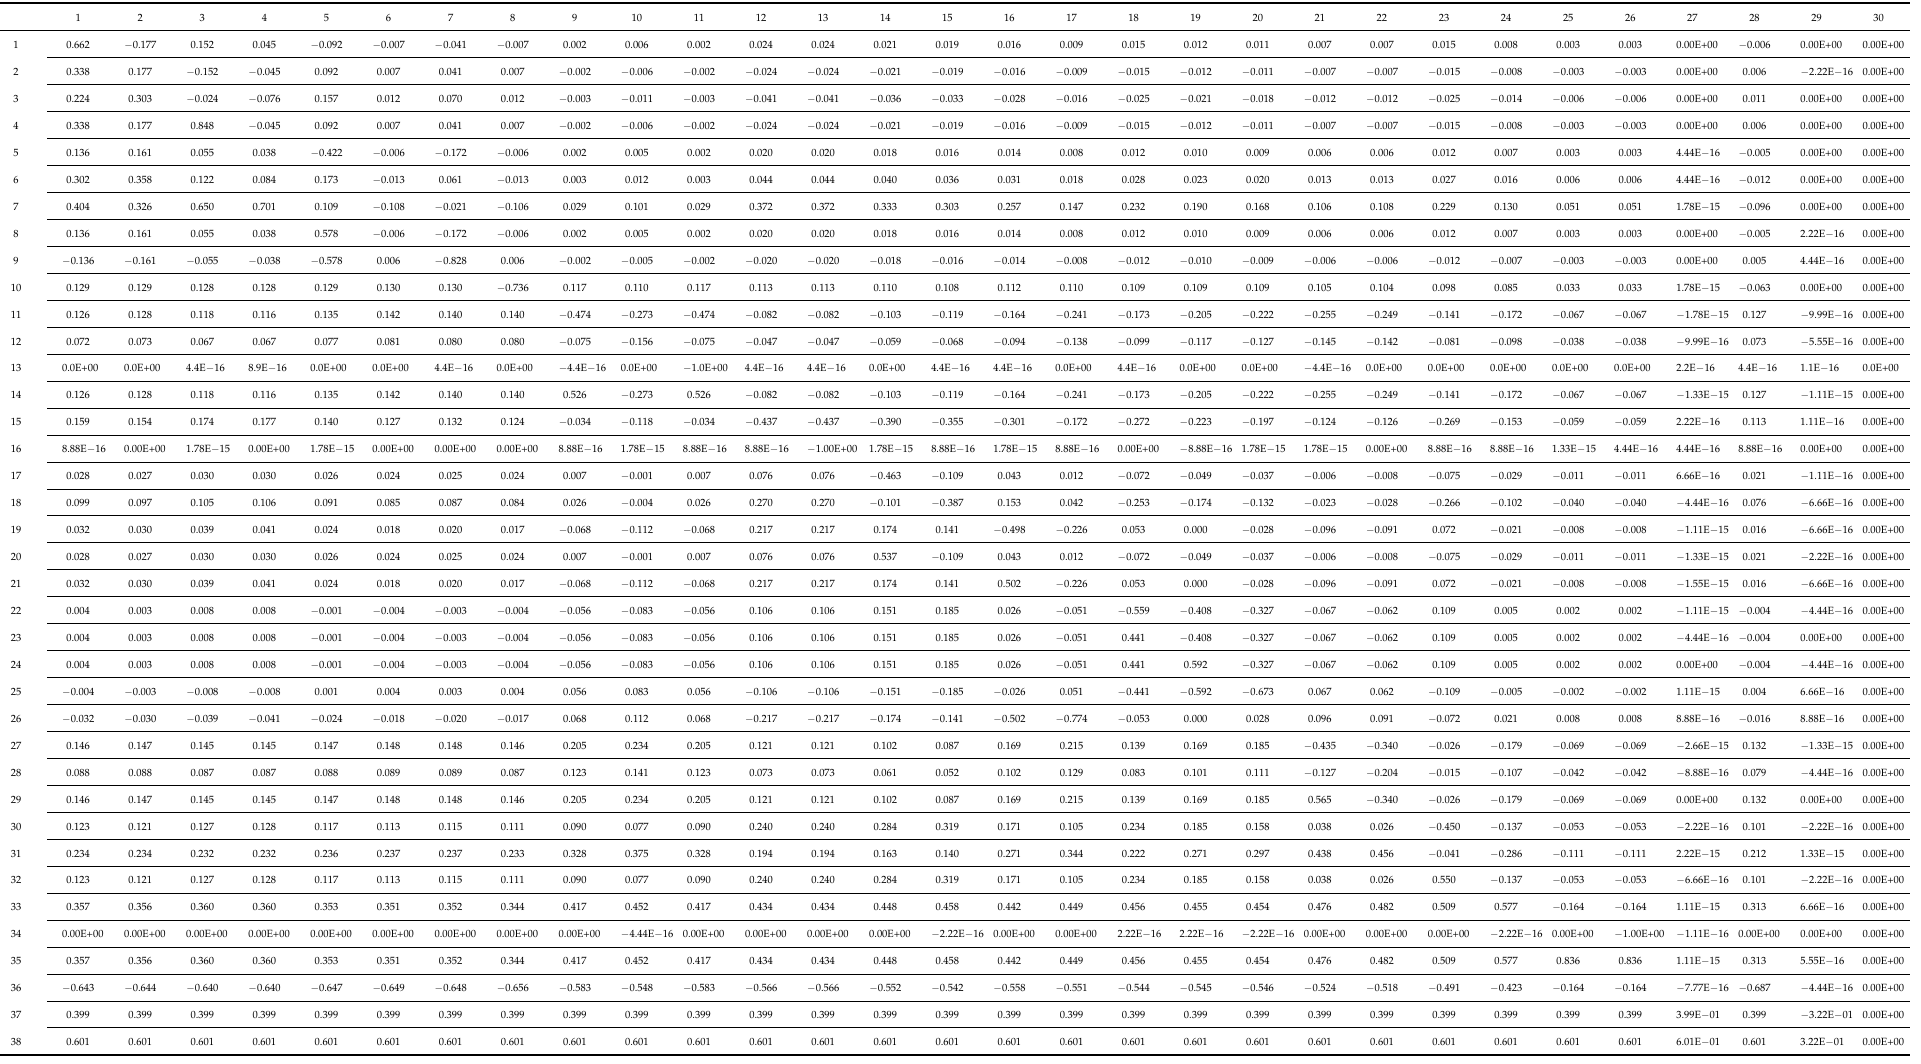
Table 5. Shift factor matrix IEEE 30 test